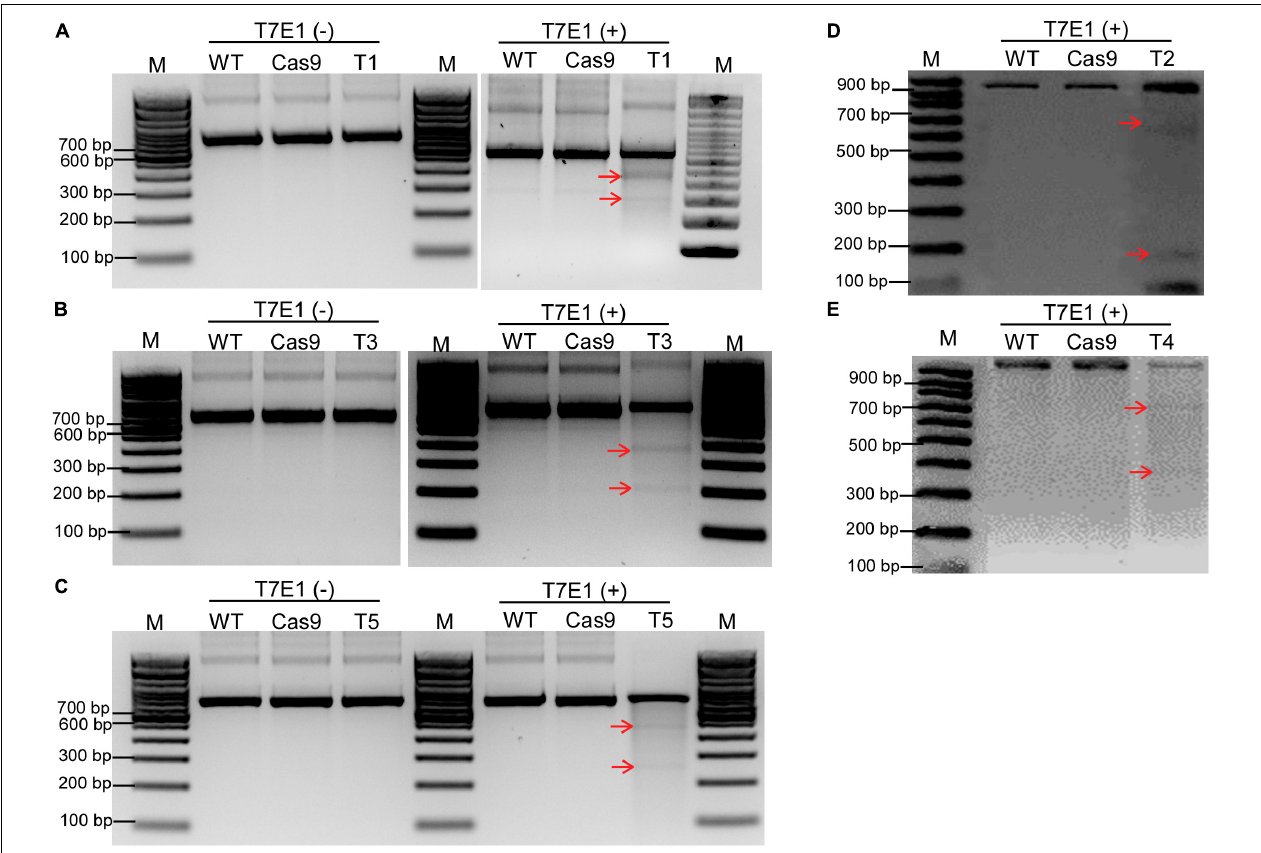
FIGURE 6 | Detection of site-directed mutagenesis at target sites on GmCPR5 loci using direct delivery of RGEN RNPs. (A–E) T7E1 digestion resulting gel images for the transformants of T1–T5. Lanes M, DNA ladder; WT, untransformed wild type (control) to each target site; Cas9, transformed with SpCas9 only; T1–T5, transformed with RNPs; T3T7E1(–), negative control (undigested). Cleaved fragments are indicated with red arrows. Images 6E and 6F have been processed for better visualization of bands. This process is in accordance with Frontiers Policies and Publication Ethics